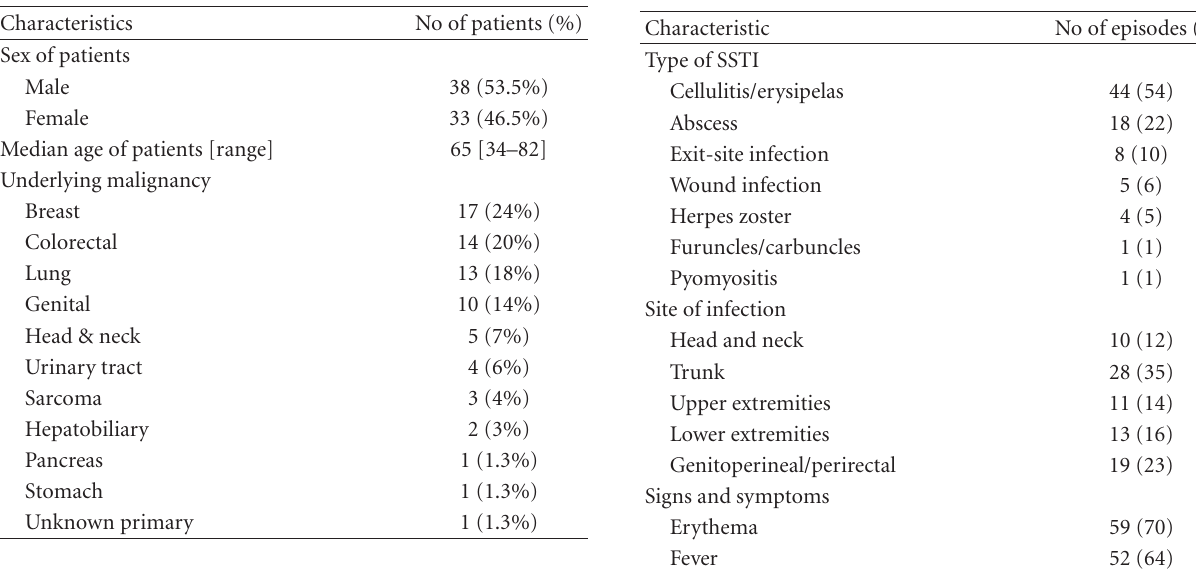
Table 1: Patients’ characteristics.